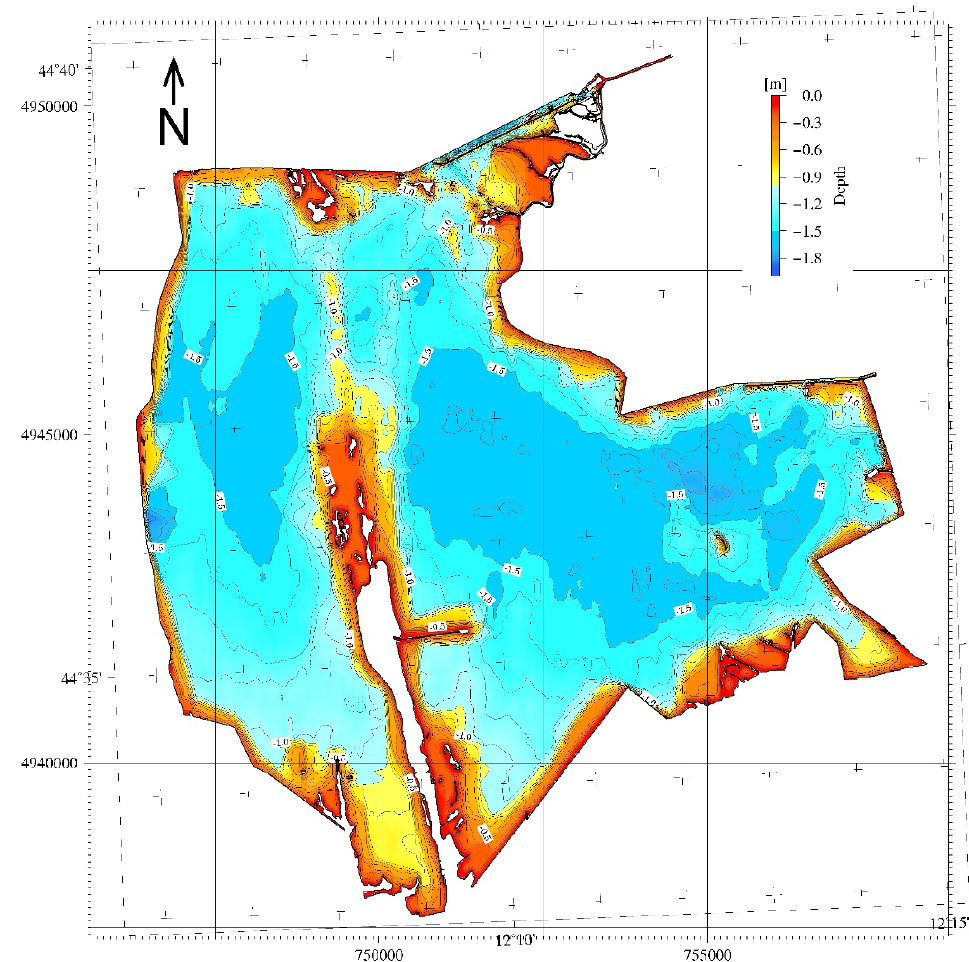
Figure 8. Morphobathymetric map of the Valli di Comacchio lagoons compiled using the newly collected dataset (Isolines each 0.5 m; Projection UTM 32N).